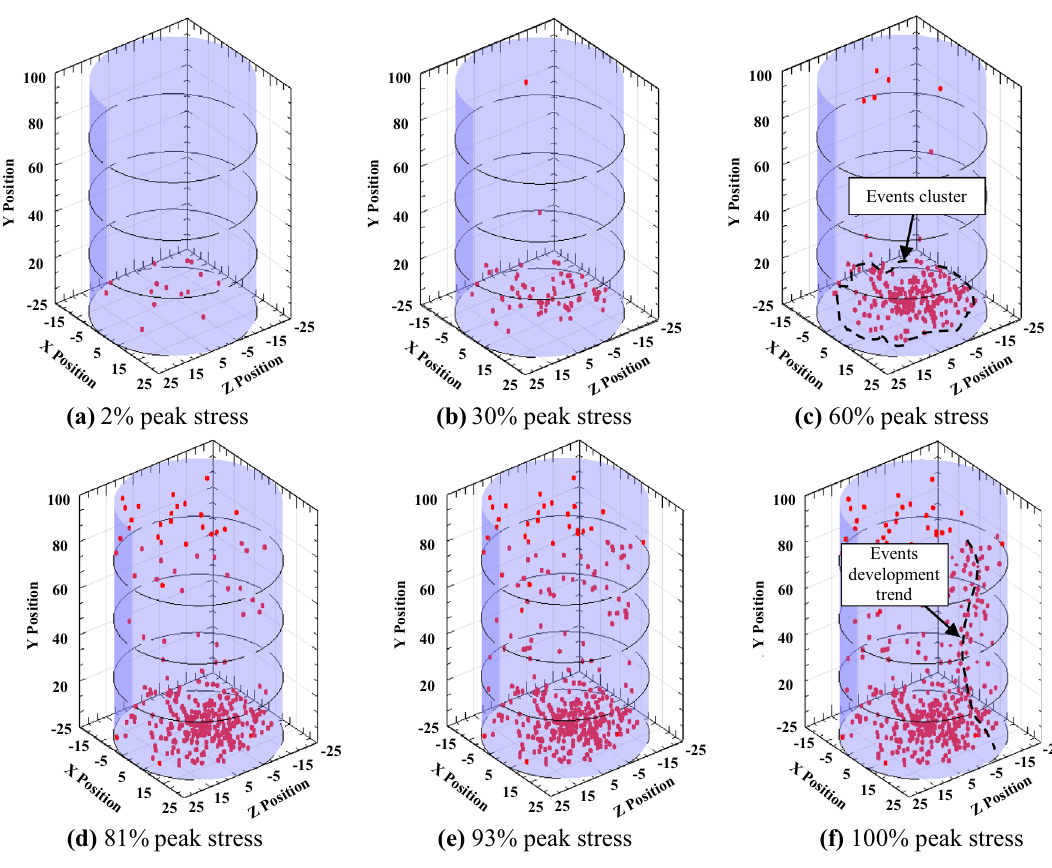
Fig. 9 AE events localization results for specimen